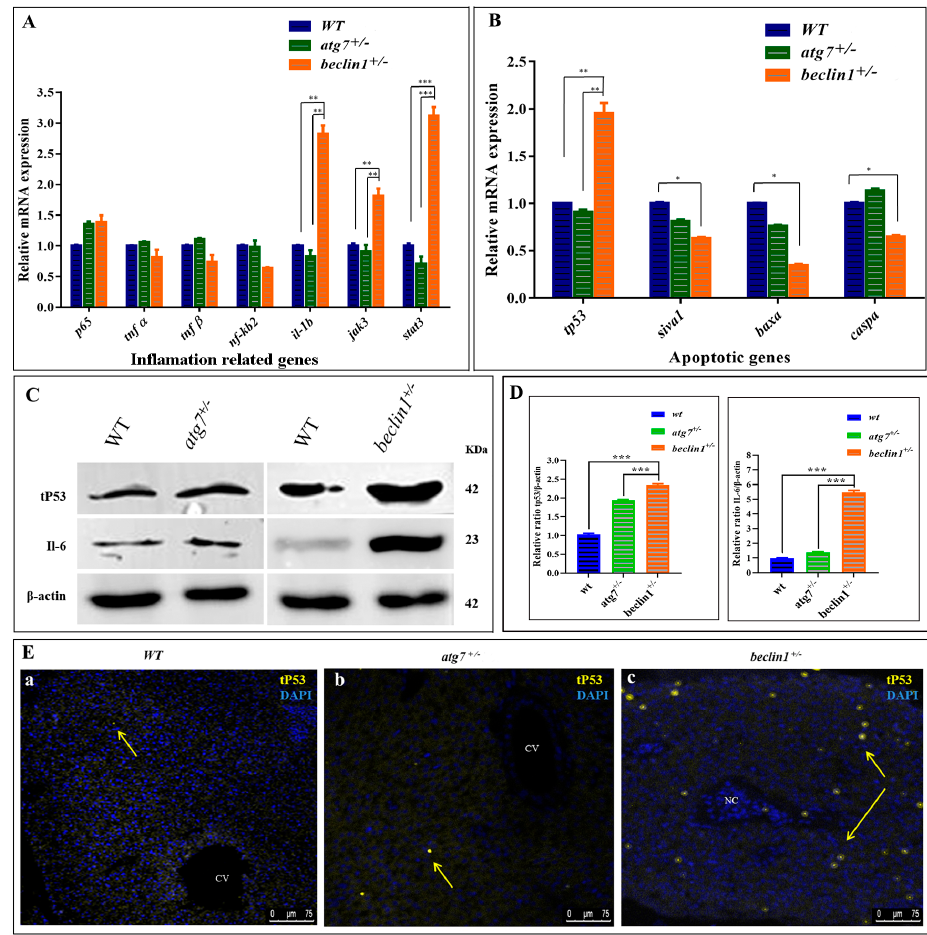
Figure 6. Abnormal apoptosis and inflammation response in beclin1 +/ − liver. Expressions of mRNA in 16-month-old zebrafish evaluated by qRT-PCR for inflammation-related genes ( A ) and apoptotic-related genes ( B ). ( C ) Representative immunoblots showed the relative protein expression of tP53, IL-6. β -actin was used as the vehicle control. ( D ) The ratio of tP53 / β -actin and IL-6 / β -actin evaluated by NIH software Image J. ( E ) Immunofluorescence of liver tissues probed against mutated tP53. The nuclei of the necrosis hepatocytes indicated the genomic instability and DNA damage in tumor cells (yellow arrows). CV: central vein; NC: Necrosis. Data expressed as mean ± SD. * p < 0.05, ** p < 0.01, and *** p <